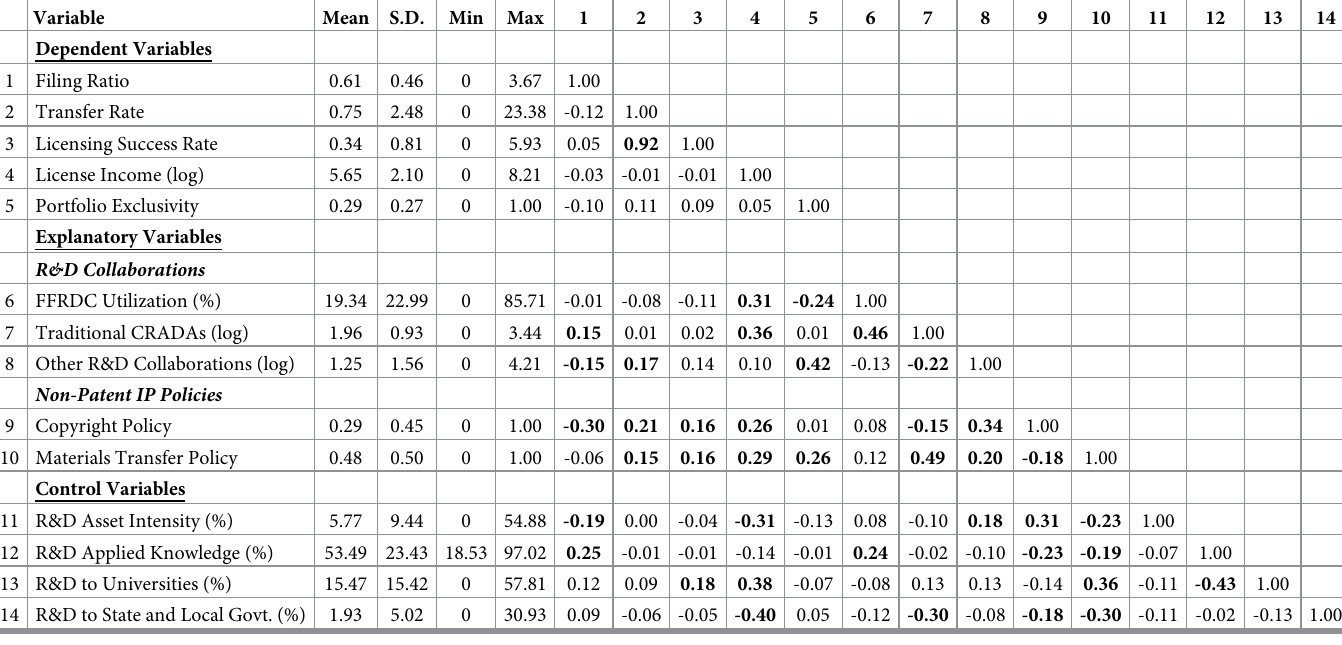
Table 1. Descriptive statistics and correlations (full sample